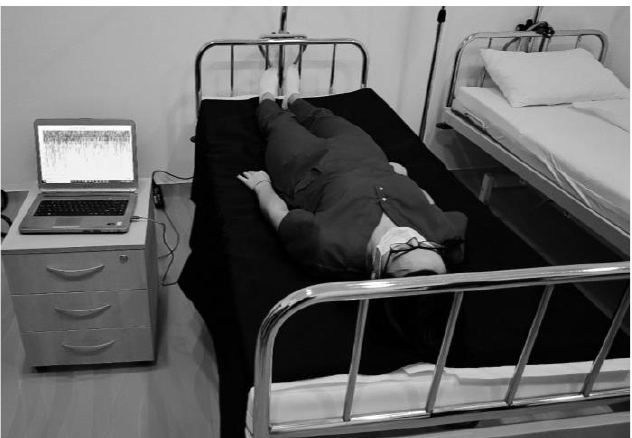
Figure 5. Preliminary real-life test